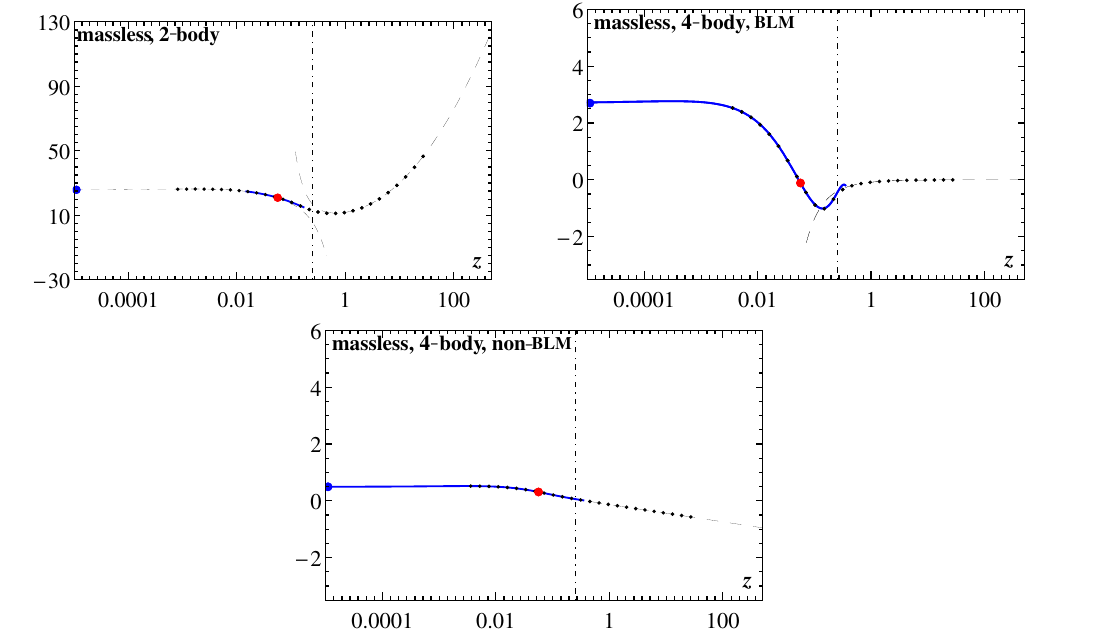
Figure 3 . Contributions to ^ G (2) from diagrams with closed loops of massless fermions | see the 27 text. They have already been multiplied by n l = 3, i.e. the number of (cid:13)avours we treat as